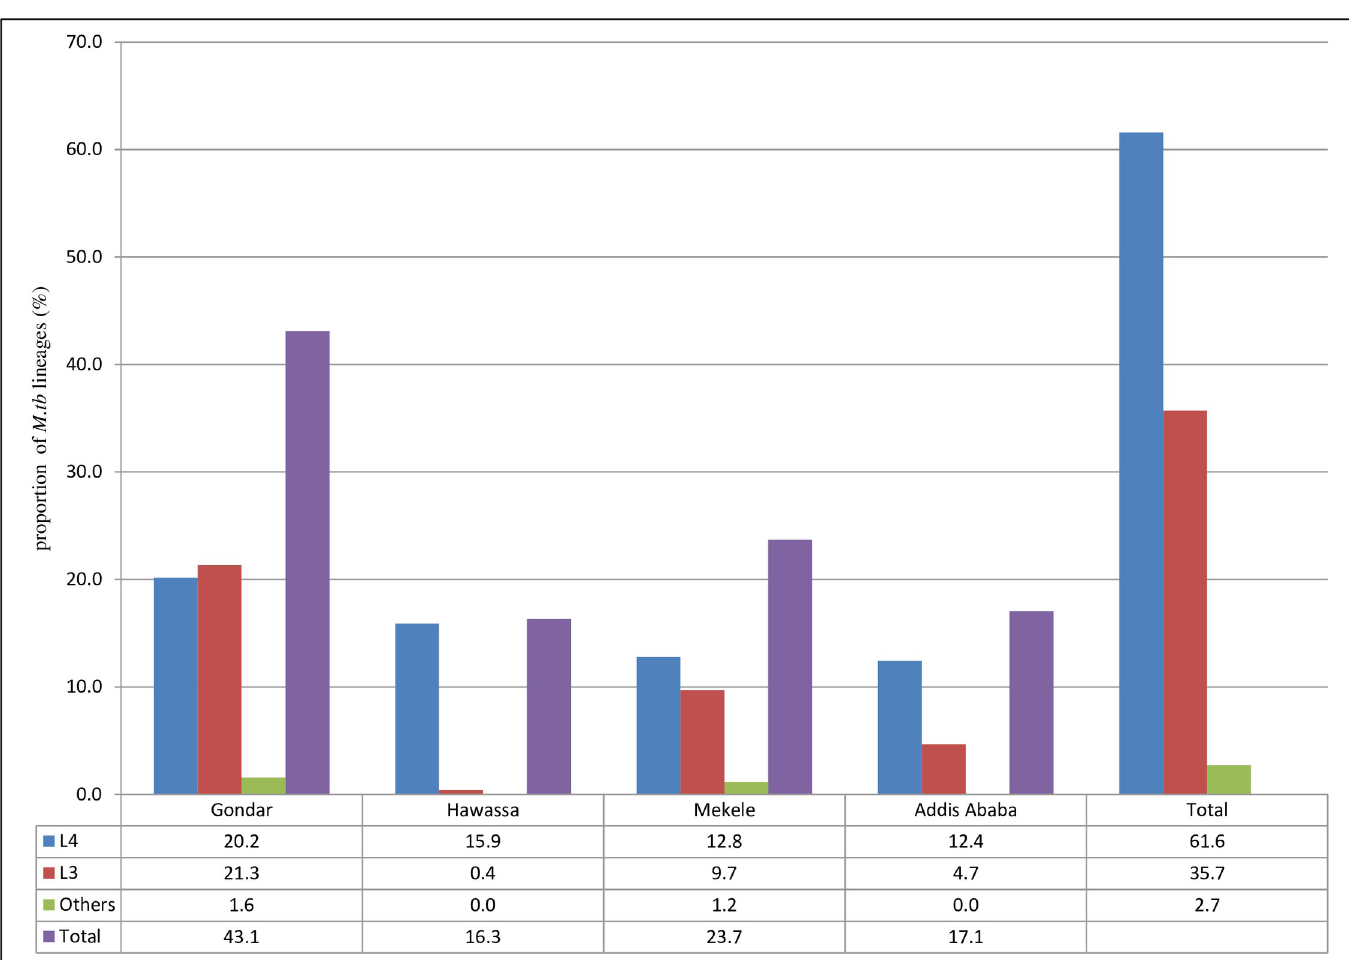
Fig 1. Proportion of major Mycobacterium tuberculosis lineages circulating within peri-urban and urban areas in Ethiopia. ‘Others’ include L7 (AFRI), L2 (Beijing), and L1 (IO).